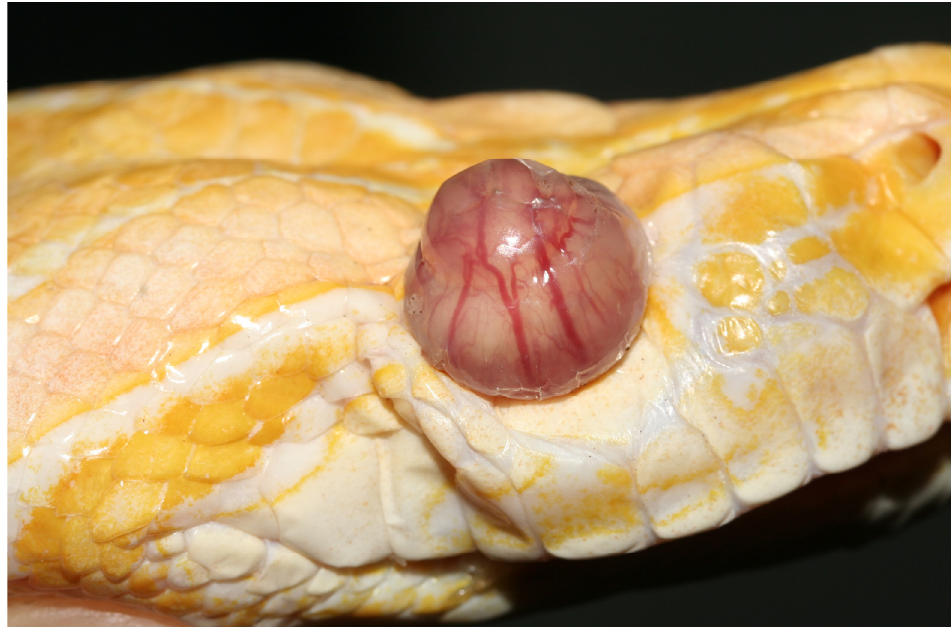
Figure 33. Prominent engorgement of blood vessels as well as severe distention and deformation of the spectacle as observed in a Burmese python ( Python bivittatus ), indicating chronic subspectacular abscessation.